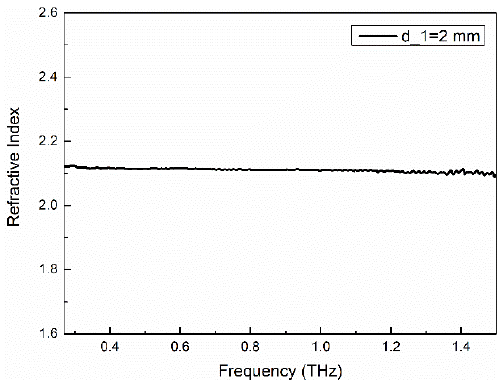
Figure 6. The THz refractive index spectra of the flaked stone thickness of 2 mm.